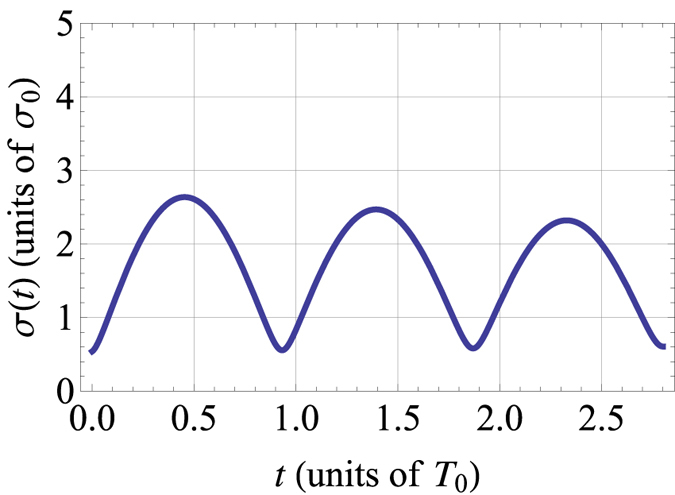
Damped oscillation of σ(t) with time t for ai = 200a0, af = 5ai.